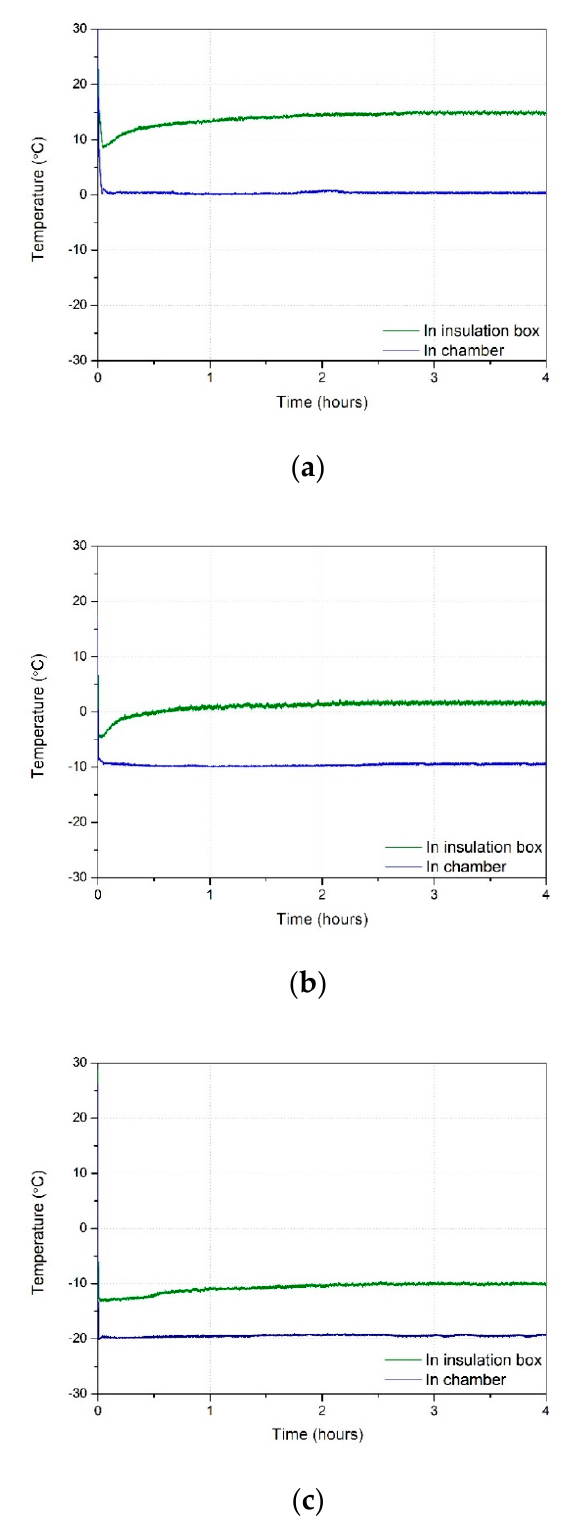
Figure 5. Temperature versus time at a chamber temperature of ( a ) 0 °C, ( b ) − 10 °C, and ( c ) − 20 °C inside and outside the insulation box.